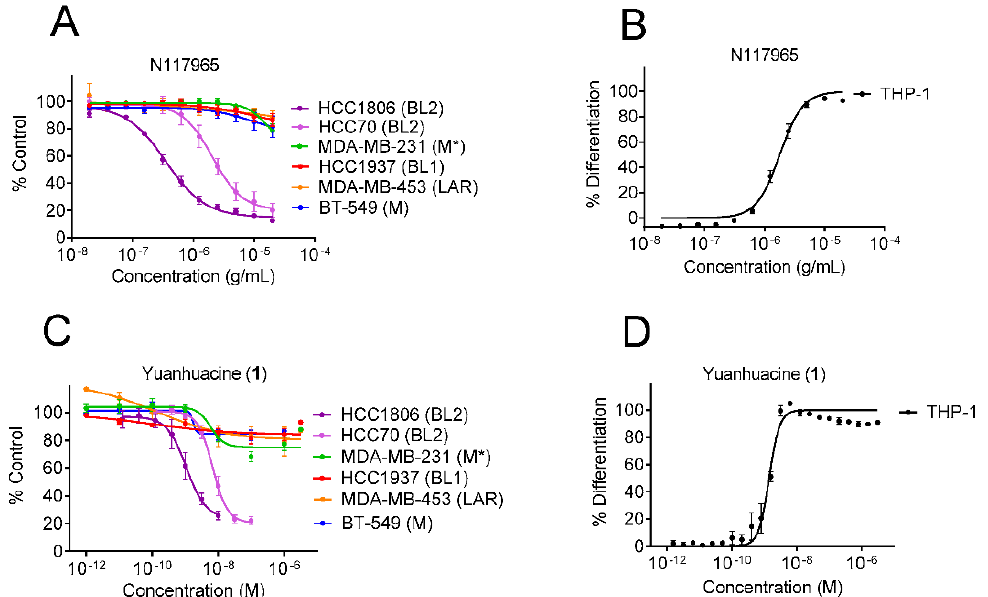
Figure 1. Yuanhuacine selectively inhibits the growth of cell lines that represent the BL2 TNBC subtype and promotes THP-1 differentiation. ( A ) Concentration response curves of the growth of cells that represent diverse TNBC molecular subtypes when treated with crude N117965 extract for 48 h. * The MDA-MB-231 cell line was originally classified as the MSL subtype and regrouped into the consolidated M subtype due to its mesenchymal phenotype. ( B ) Concentration response curve of THP-1 cell differentiation when treated with crude N117965 extract for 24 h. ( C ) Concentration response curves of the growth of cells that represent diverse TNBC molecular subtypes when treated with 1 for 48 h. ( D ) Concentration response curve of THP-1 cell differentiation when treated with 1 for 24 h. Error bars indicate the SEM of 2–4 biological replicates.